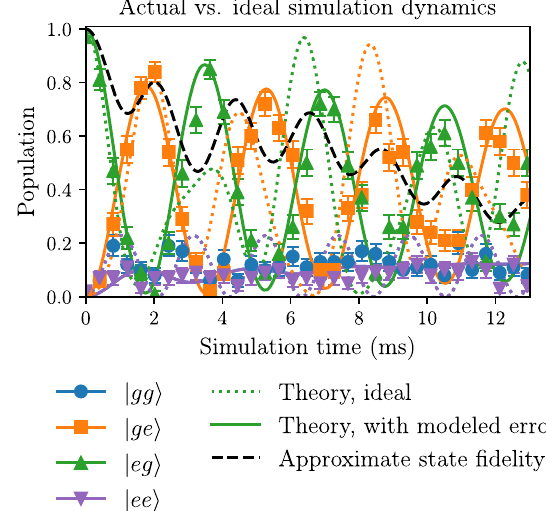
Fig. 6 Experimentally-measured dynamics of the simulation as a function of time. Each data point is the average of 100 independent runs. Error bars indicate standard error of the mean. The dotted curves represent the ideal dynamics of a perfectly-calibrated analog simulation ( J = 2 π × 139 Hz, b = 2 π × 227 Hz) in the absence of noise. The solid curves represent the theoretical dynamics of a miscali- brated analog simulation ( J = 2 π × 250 Hz, b = 2 π × 102 Hz) with a dephasing rate of γ ϕ = 2 π × 38 Hz, where these parameters are chosen empirically as a reasonable approximation of the observed experimental data points. The dashed curve is the fi delity of the state evolved according to the miscalibrated dynamics with the state evolved according to the ideal dynamics, calculated using Eq.